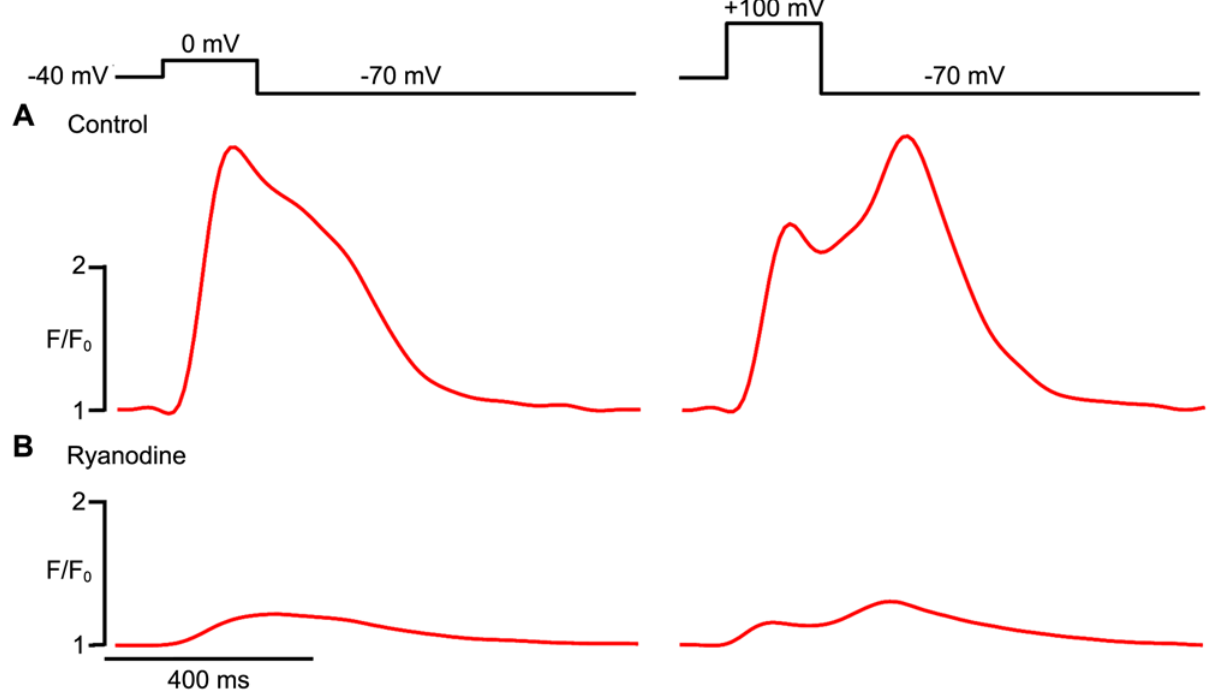
Figure 4. Tail [Ca 2 + ] i transients in hESC-CMs. A. [Ca 2 + ] i traces from a representative hESC-CMs during a 200 ms step depolarization from 2 40 mV to a test potential of 0 mV (left) or + 100 mV (right), followed by a repolarization to 2 70 mV. Note the large tail [Ca 2 + ] i transient evoked by repolarization from + 100 mV in the record to the right. B. Corresponding [Ca 2 + ] i traces elicited by the same voltage protocols after treatment with ryanodine (10 m M).